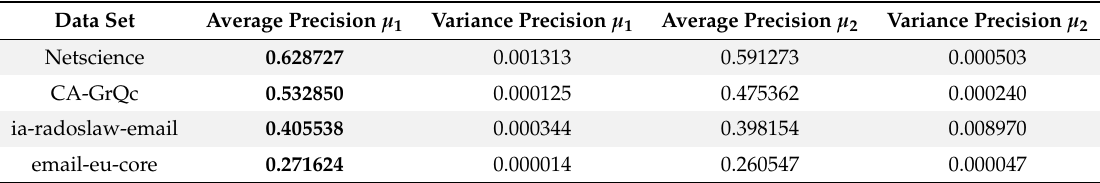
Table 6. Average precision and Variance, RAND/1/BIN strategy. Best performance in